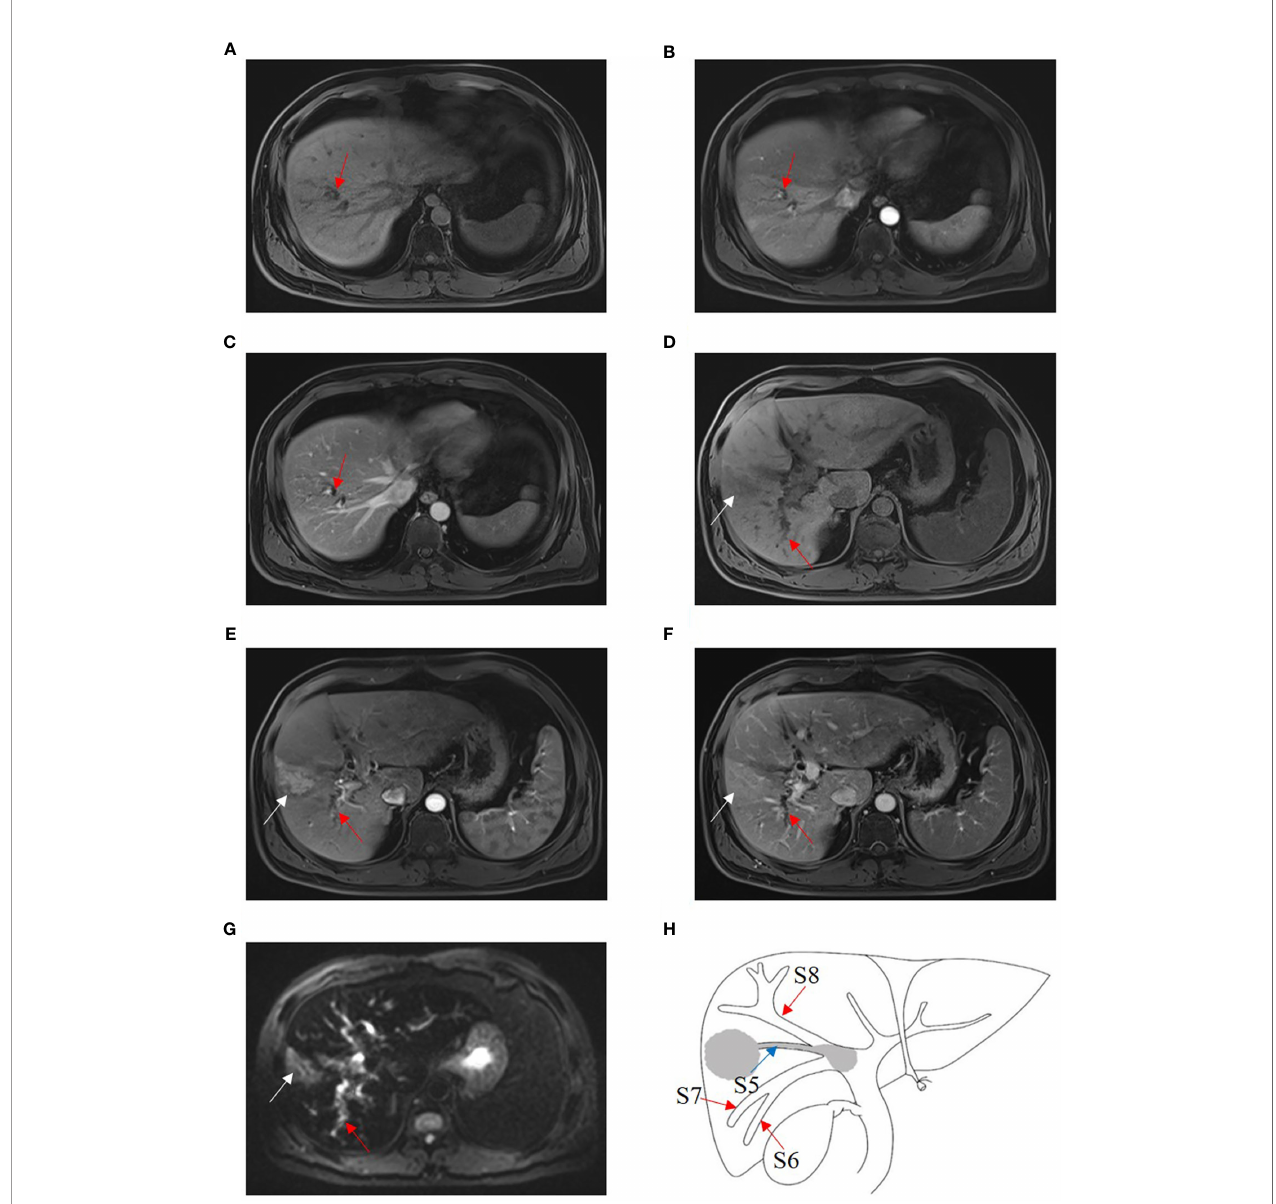
FIGURE 5 | HCC with B3 BDTT. Bile duct dilation (red arrow) in S8 show slightly hypoattenuation on T1W (A) , arterial phase (B) , and portal venous phase (C) . HCC lesion locates (white arrow) in S5 and shows hypoattenuation in T1 phase (D) , enhancement (white arrow) at arterial phase (E) , and hypoattenuation (white arrow) at portal venous phase, accompanied by bile duct dilation (red arrow) in right posterior hepatic lobe (F) . (G) HCC lesion (white arrow) in S5 and bile duct dilation (red arrow) in the right posterior hepatic lobe show hyperintensity, and the bile duct tumor thrombus in the right hepatic duct shows hypointensity on fat-suppressed T2W. (H) HCC lesion, BDTT, and bile duct dilation (red